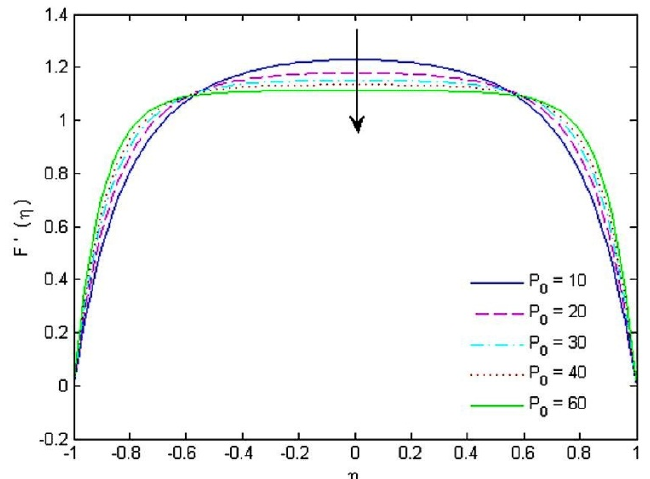
Figure 4. Change in angular velocity for various values of magnetic parameter M 0 .